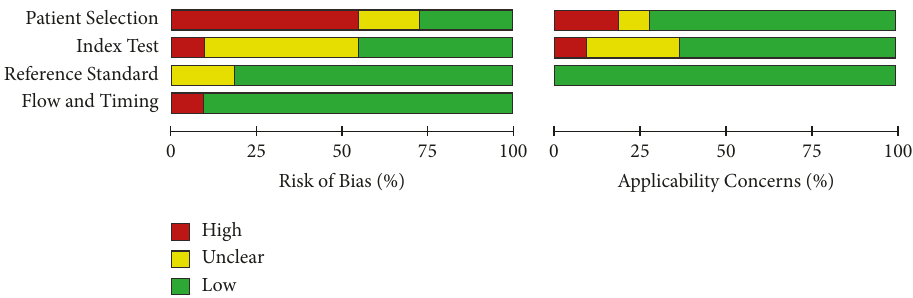
Figure 2: The risk of bias in the studies conducted was measured by using the QUADAS-2 Table 1: Basic characteristics and quality evaluation of the included studies.